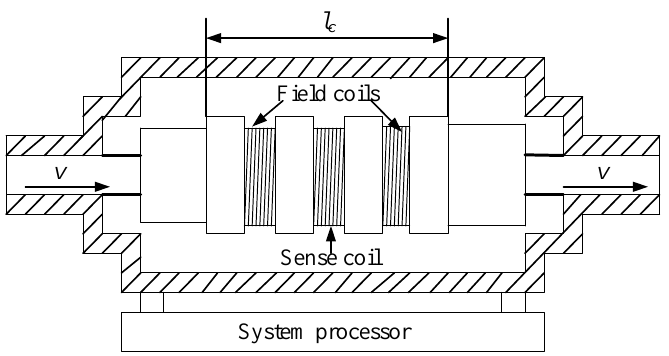
Figure 1. Schematic illustration of an oil debris sensor. v